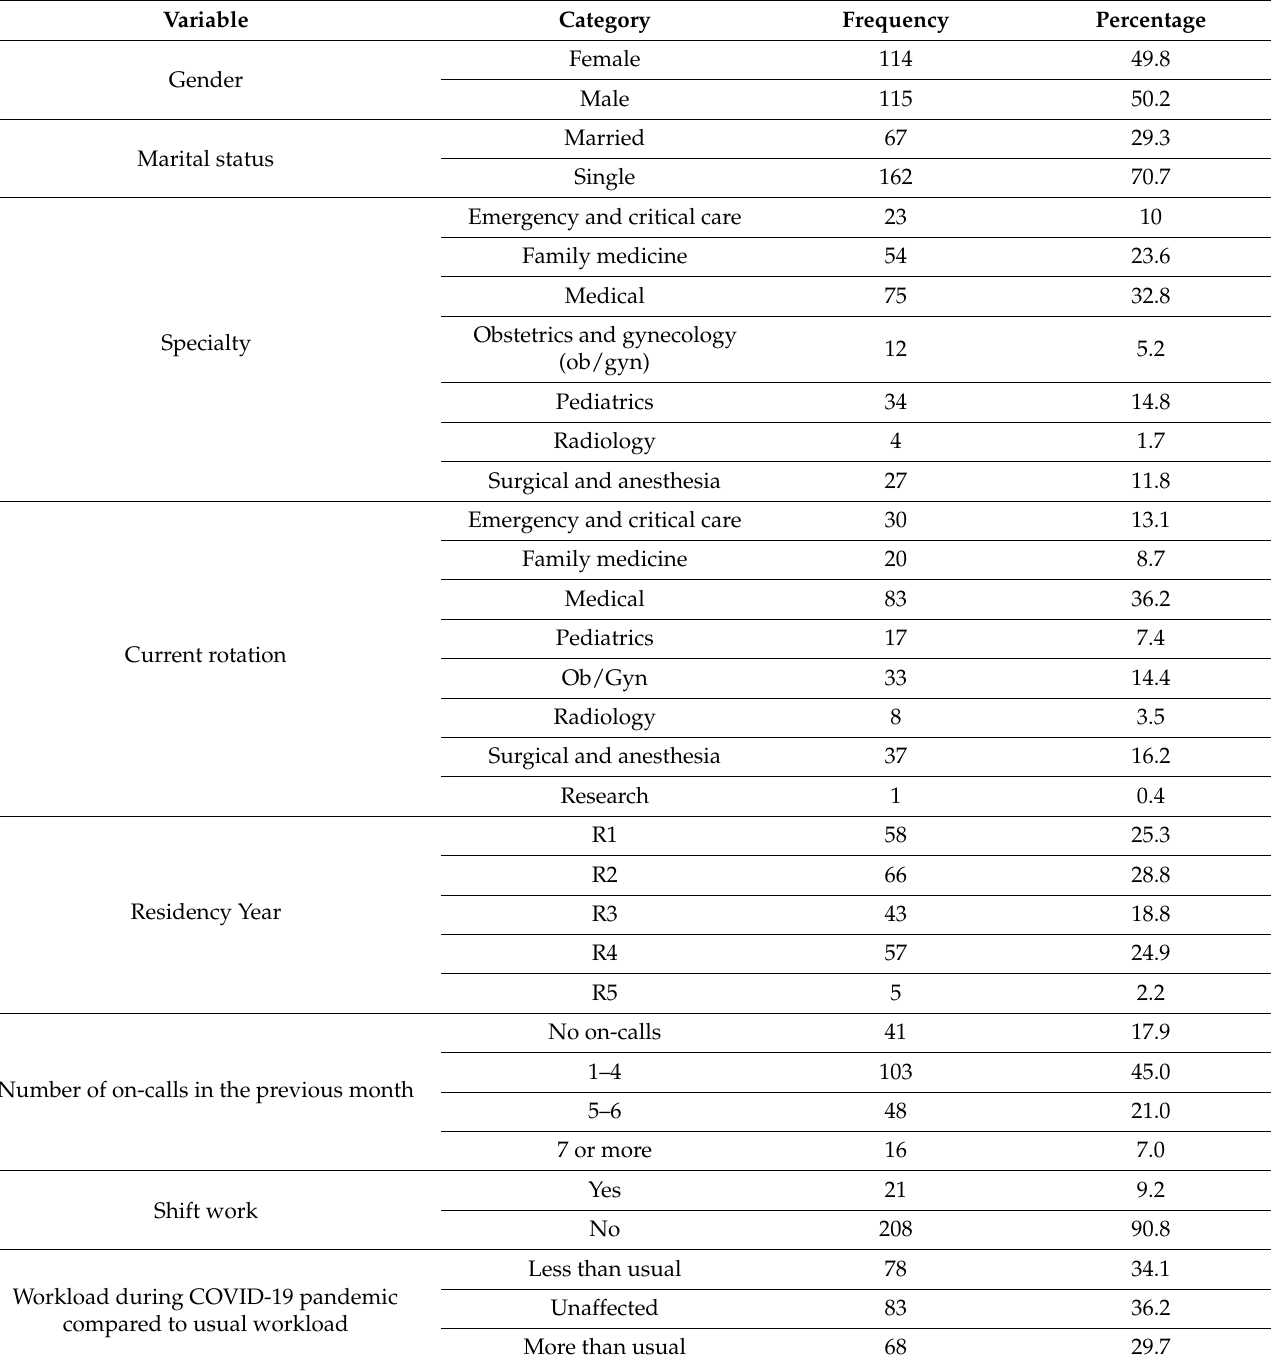
Table 1. Sociodemographic, residency-related, and workload characteristics of participating residents ( n =